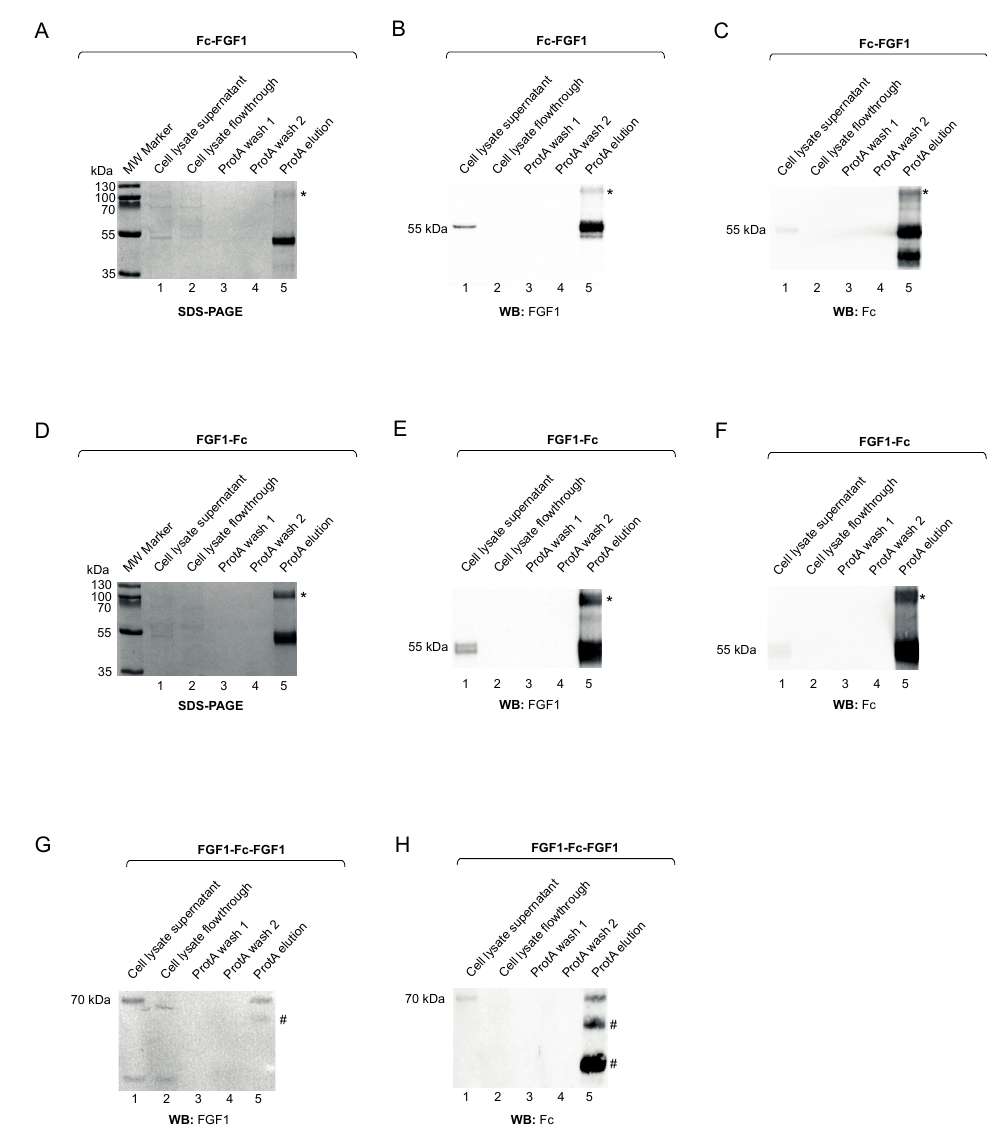
Figure 3. Purification of Fc-fused proteins. Fc-FGF1 ( A ), FGF1-Fc ( D ), and FGF1-Fc-FGF1 ( G ) were purified by protein A affinity chromatography. Protein purity was analyzed by SDS–PAGE (CBB staining) ( A , D ) and Western blotting with antibodies recognizing the FGF1 and Fc fragment ( B , C , E – H ). *—putative determination dimeric form of the protein, #—putative degradation products.